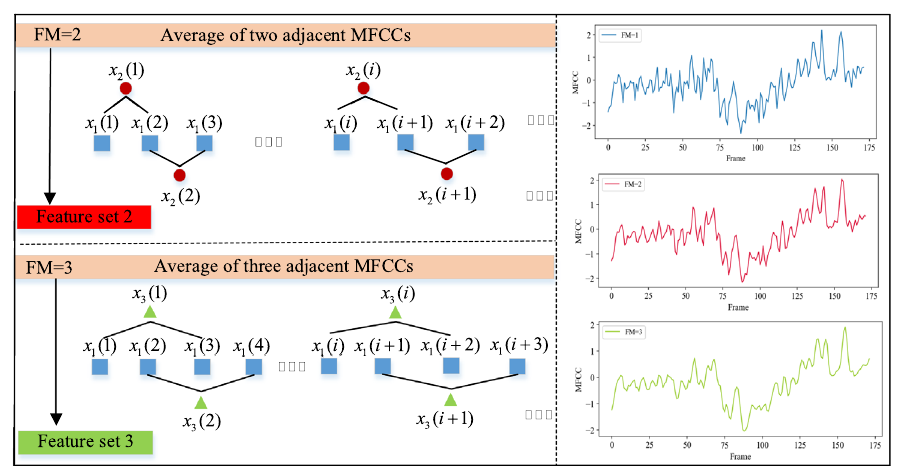
Figure 2. Description of MFCC feature smoothing processing method (FM = 2,